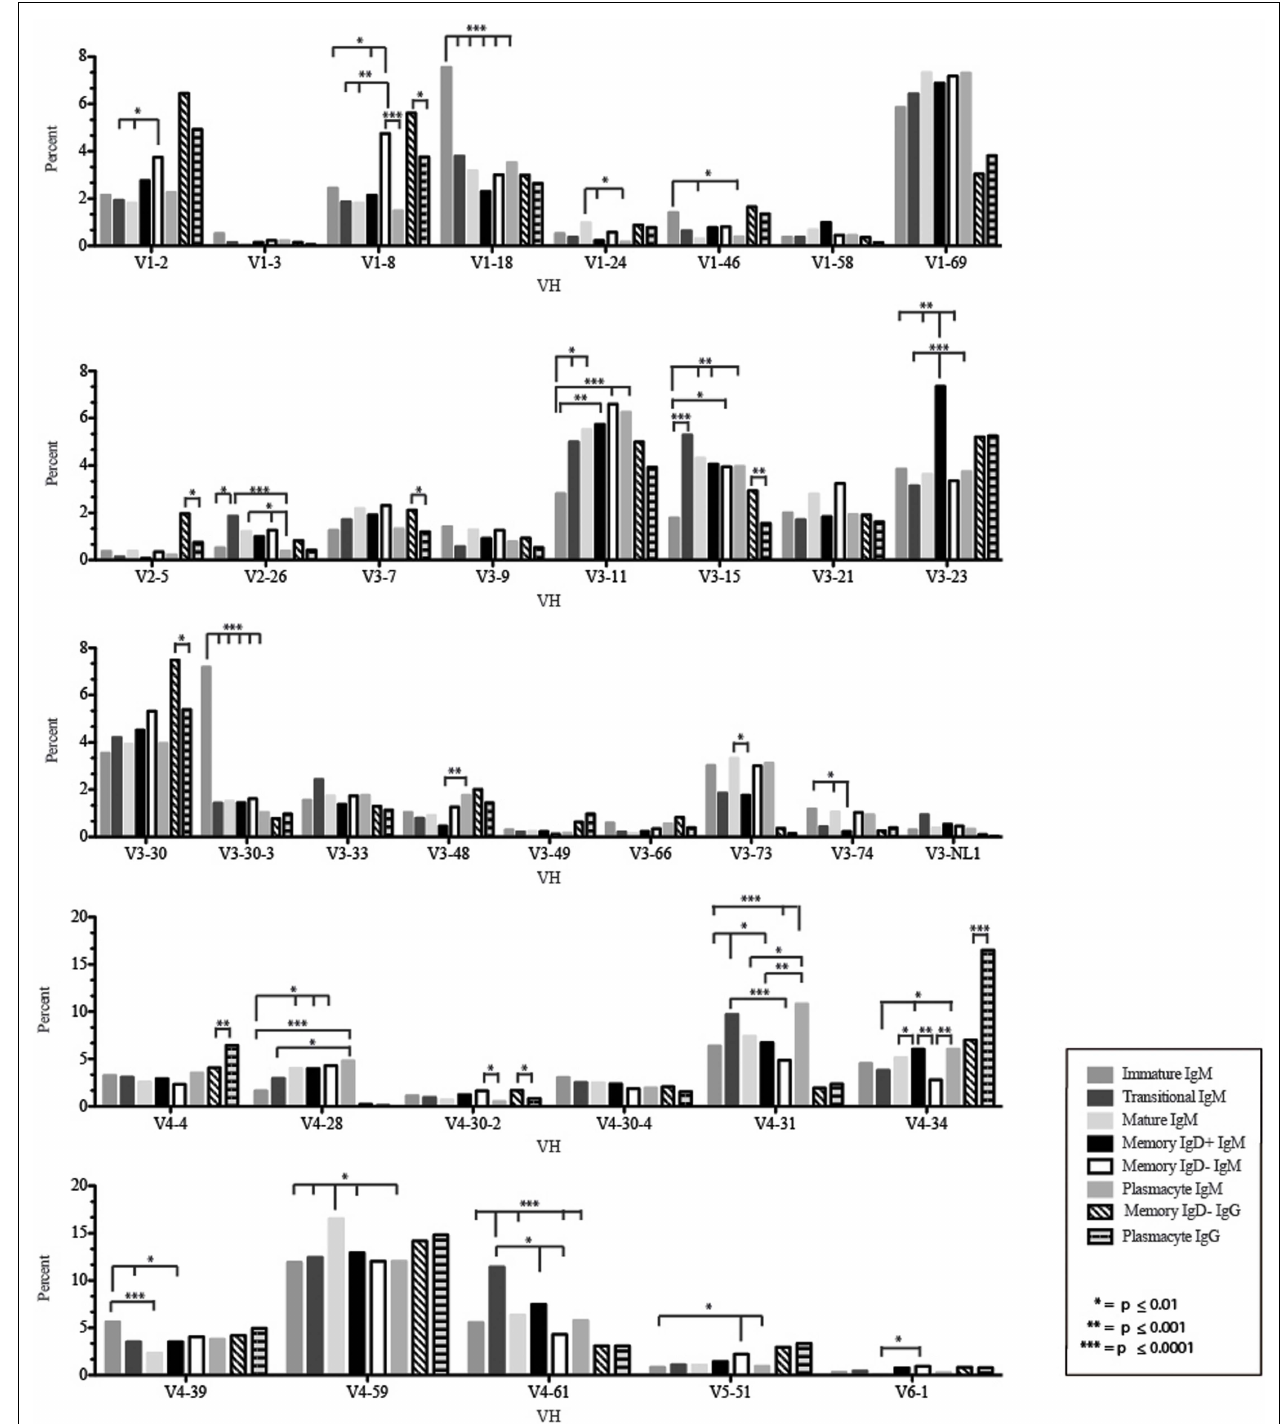
mature, memory IgD + , memory IgD − B cells, and plasmacytes are displayed. All comparisons were made using χ 2 -test or Fisher’s exact test as appropriate. Significant differences among each fraction in the different mice are indicated by asterisks: * p ≤ 0.01, ** p ≤ 0.001, *** p ≤